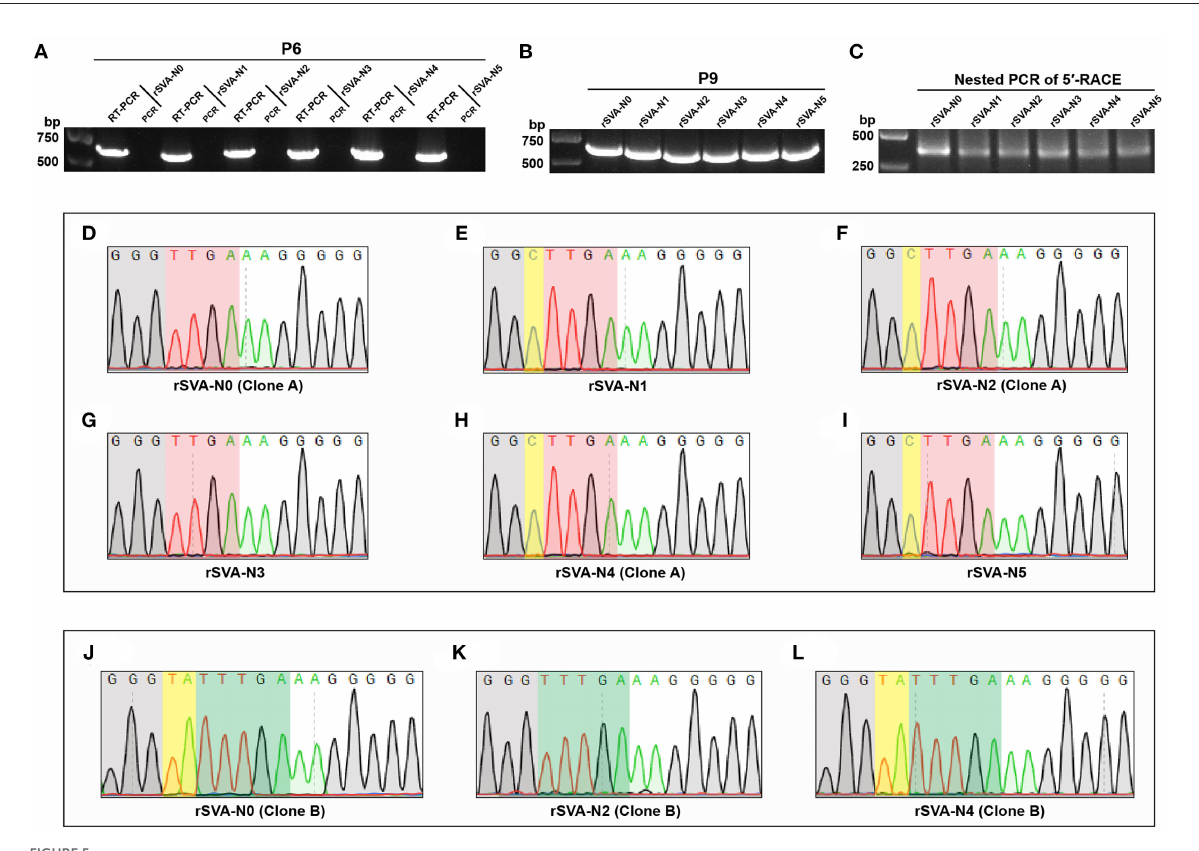
FIGURE5 RT-PCR detection, 5 ′ -RACE analysis and Sanger sequencing. RT-PCR detection of rSVA-N0 to -N5 at P6 (A) . PCR controls are assigned to demonstrate no interference of cDNA residues. RT-PCR detection of rSVA-N0 to -N5 at P9 (B) . Nested PCR amplification for 5 ′ -RACE products of rSVA-N0 to -N5 at P9 (C) . Sanger sequencing chromatograms of 5 ′ -end sequences of rSVA-N0 to -N5 at P9 (D–L) . The “TTGA” and “TTTGA” genotypes are covered with red and green shadows, respectively. The partial 3 ′ -end sequences of adapters are covered with gray shadows. The yellow shadows indicate one or two extra nucleotides inserted between the 3 ′ end of adapter and the 5 ′ end of viral